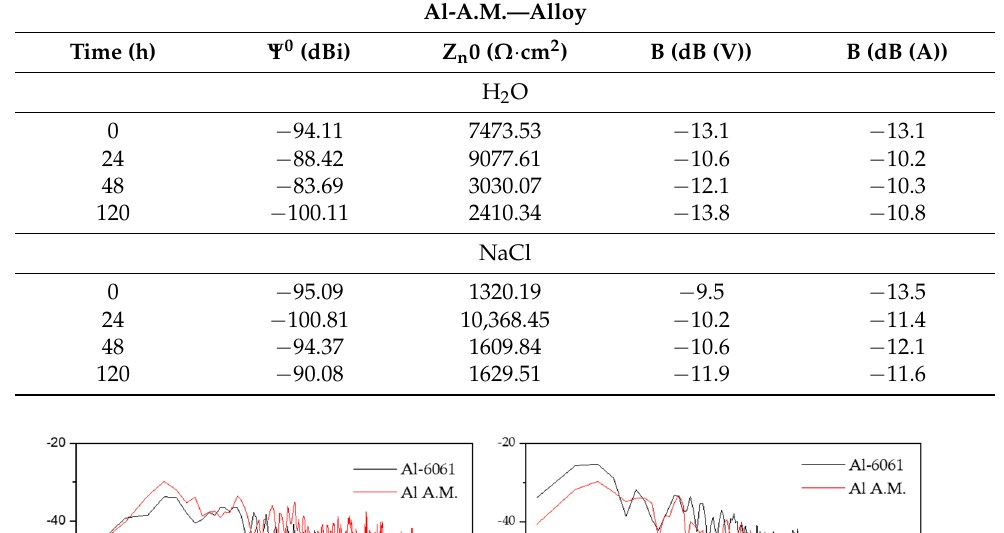
Table 6. Parameters obtained by PSD for the Al-A.M. alloy.